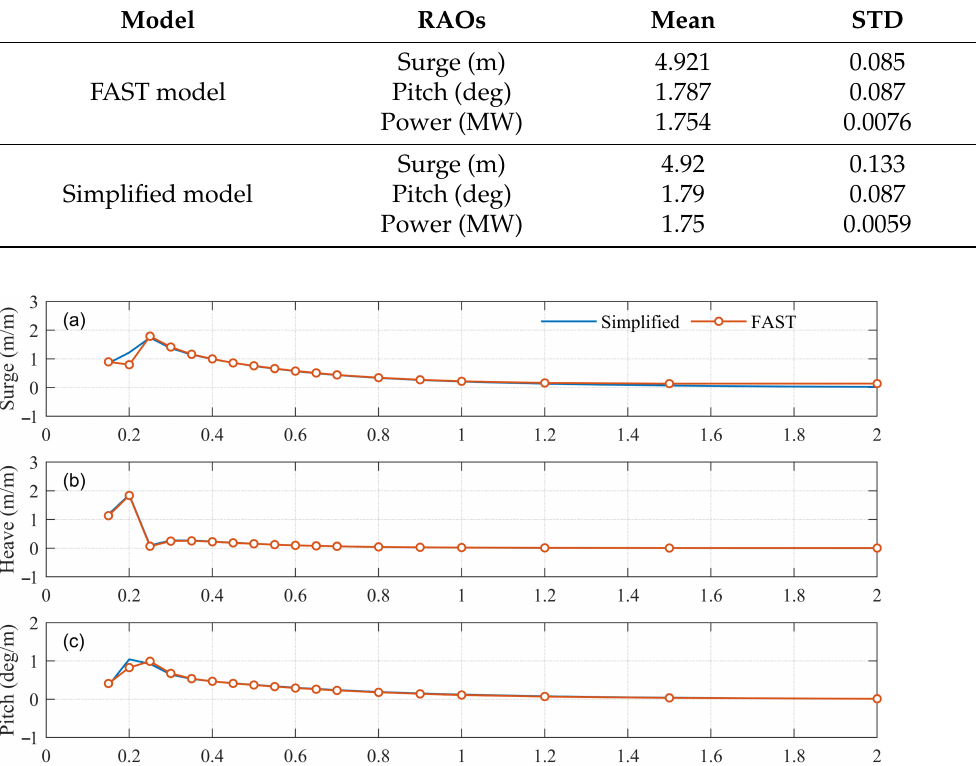
Figure 12. Output power of the semi-submersible floating turbine under an irregular wave and wind speeds of 8 m/s. Table 3. Mean and standard deviation of RAO motions and output power for the semi-submersible turbine model.